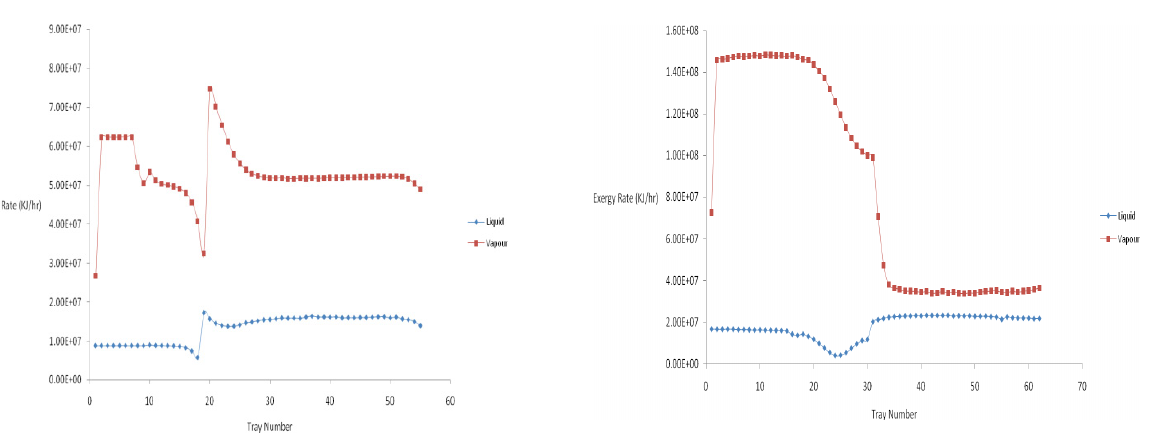
Figure 14. Profile of exergy rate versus tray number for Debutanizer of base case, 30 o C, Reflux Ratio 2